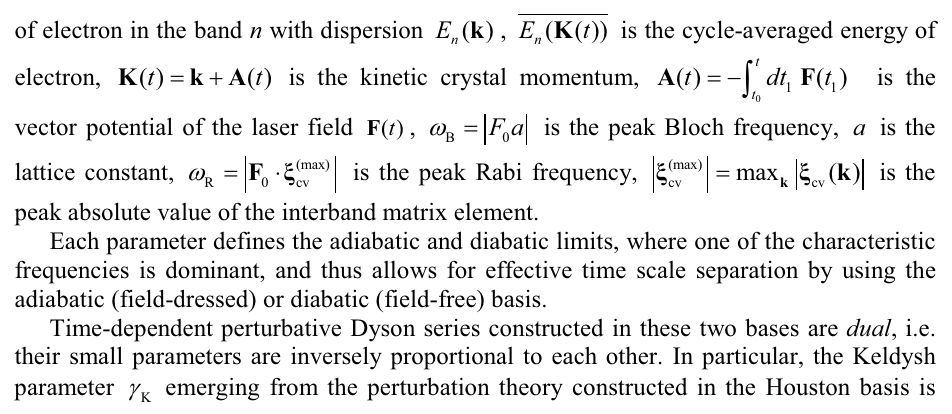
Table 3. Characteristic time scales of the laser-matter interaction problem in the Houston basis and their typical values for the bath of phonons (ph) and carrier correlations (c). The parameters are 9 E (cid:5) eV, 1.2 E (cid:5) eV, 0.153 E (cid:5) eV) and VIS/NIR laser pulses estimated for the (cid:2) -quartz ( g ex LO in the wavelength range 400–2500 nm. Time scale Denotation Values Optical cycle 0